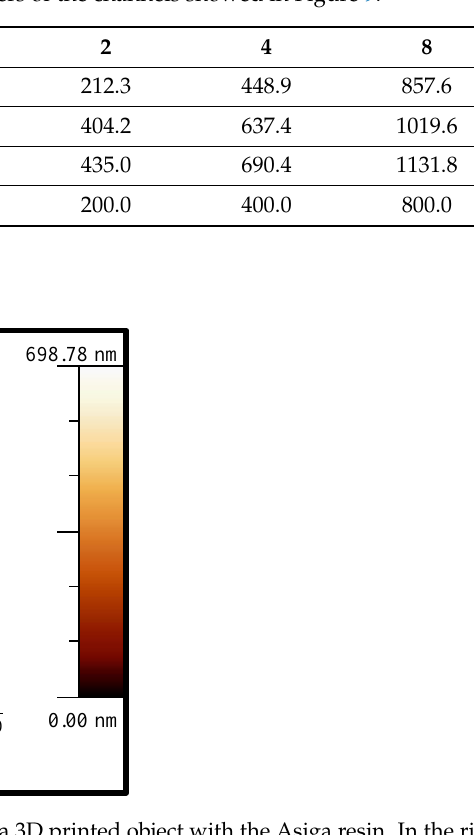
Figure A1. Figure obtained with the AFM, from a 3D printed object with the Asiga resin. In the right a heights histogram can be observed indicating the height difference in a 50 × 50 µ m